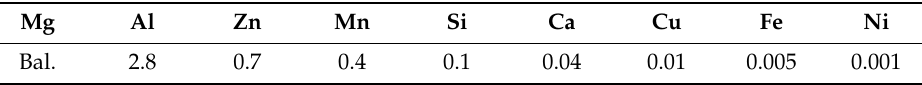
Table 1. Chemical composition of the AZ31B magnesium alloy